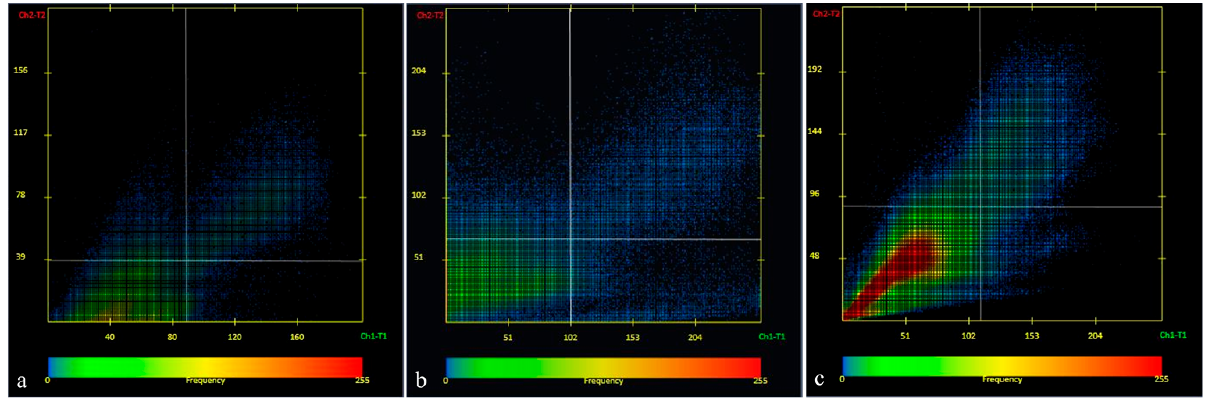
Figure 3. Scatter plot of CaB-D28K/CaR-N18 colocalization in different experimental groups: ( a ) white-light experimental group; ( b ) white/blue-light experimental group; ( c ) blue-light experimental group. Zen 2011 (LSM 700 Zeiss software, Germany).